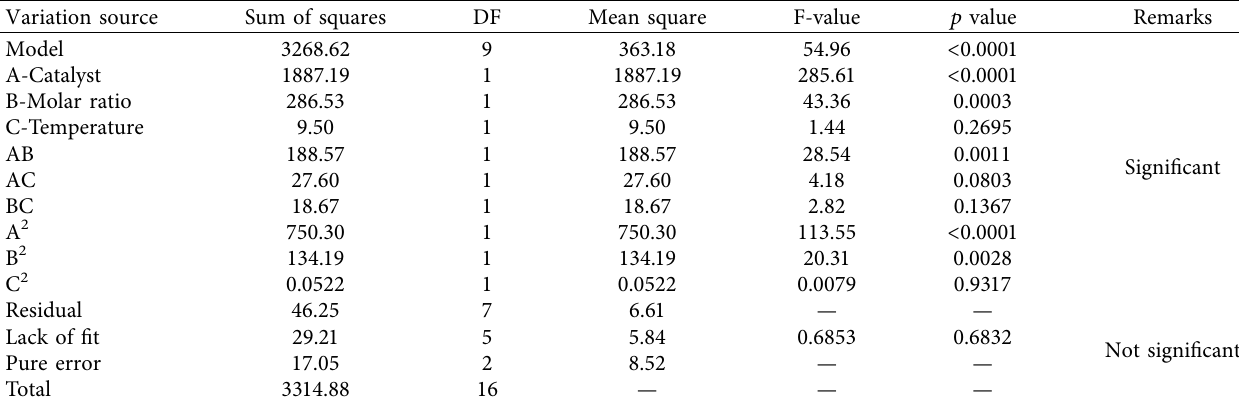
Table 5: ANOVA for the fitting response surface quadratic